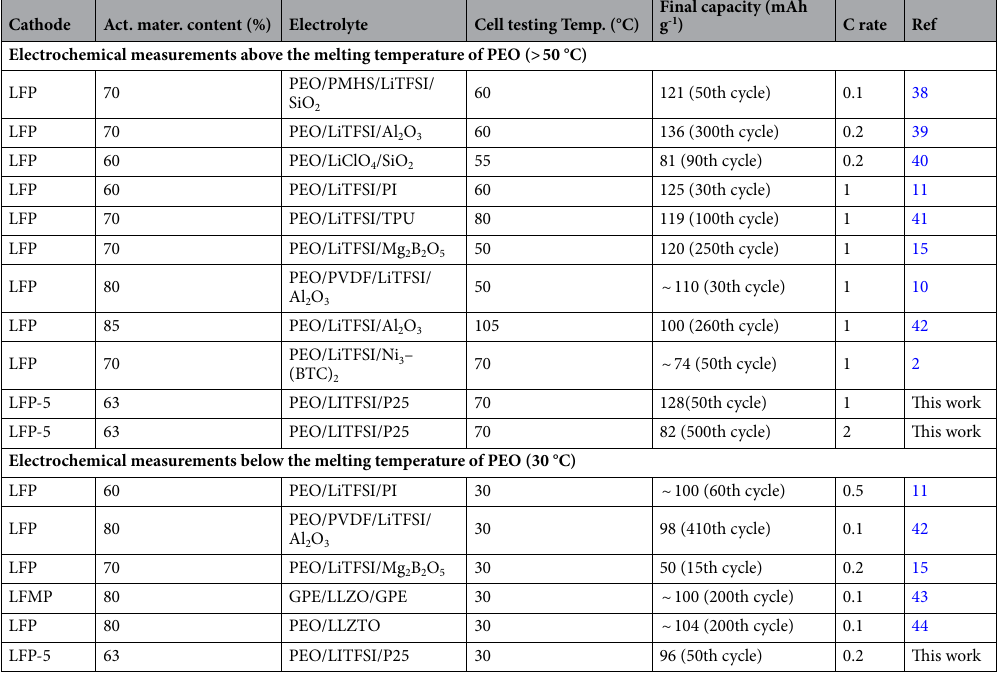
Table 5. comparison of electrochemical performance of the present Li/SPNE/LFP-5 cell with those reported in the literature.